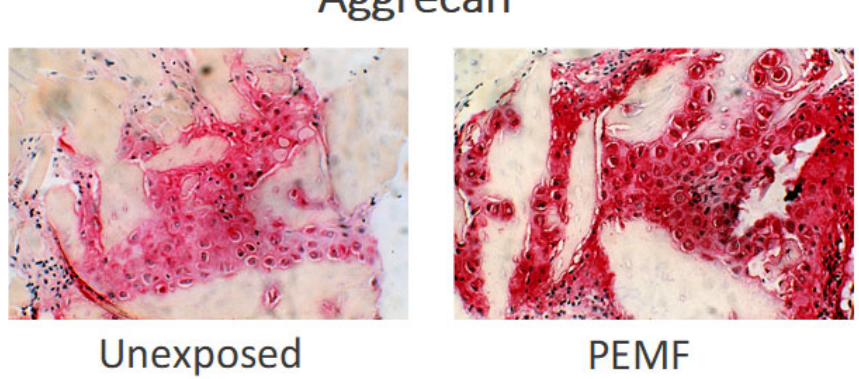
Figure 5. Immunohistochemistry of aggrecan during chondrogenesis (day 8 of ossicle development). Gray areas are DBM particles; red areas represent aggrecan. Ossicles exposed to PEMF stimulation during development form a greater amount of aggrecan than the unexposed controls, as demonstrated by increased areas and intensity of aggrecan staining